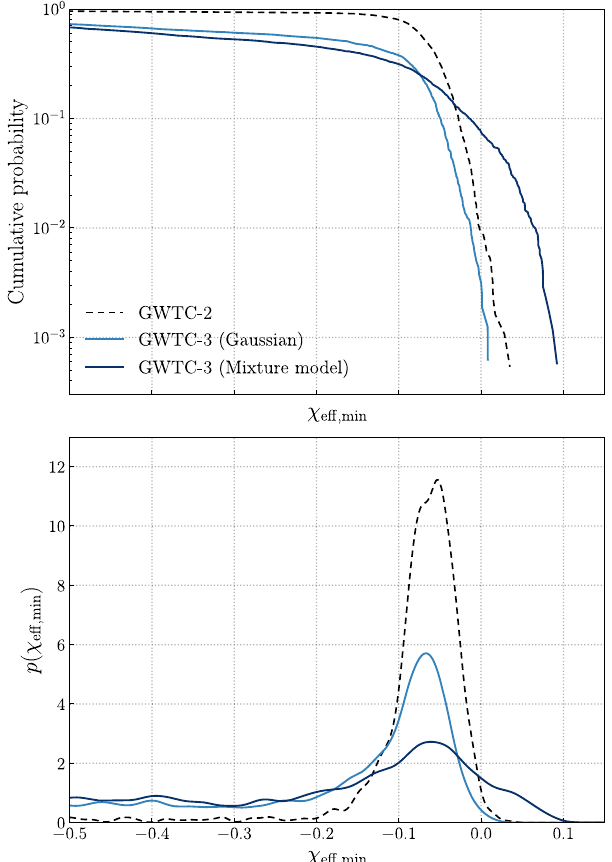
FIG. 18. Cumulative probability (top) and probability density (bottom) of the minimum truncation bound on the χ tion as inferred using GWTC-2 and GWTC-3. When modeling the effective inspiral spin distribution as a Gaussian truncated on χ ≤ χ ≤ 1 , we infer using GWTC-2 that χ eff ; min eff 99.1% credibility, and hence that the data support the existence of BBH mergers with negative effective inspiral spins. Using GWTC-3, this same analysis more strongly infers that χ < 0 , now at 99.7% credibility. As we discuss further min ; eff below, evidence for negative effective inspiral spins is diminished under an expanded model that allows for a subset of BBHs to possess vanishing effective inspiral spins. When instead model- ing the χ distribution as a mixture between a broad Gaussian eff and a narrow Gaussian subpopulation centered at χ the second consistent with zero spin), we infer χ 92.5%